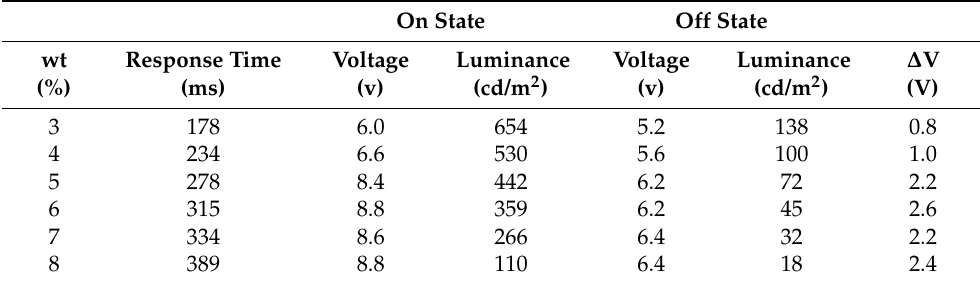
of the dye concentration at 10.0 µm of the cell gap . the dye concentration at 10.0 µ m of the cell